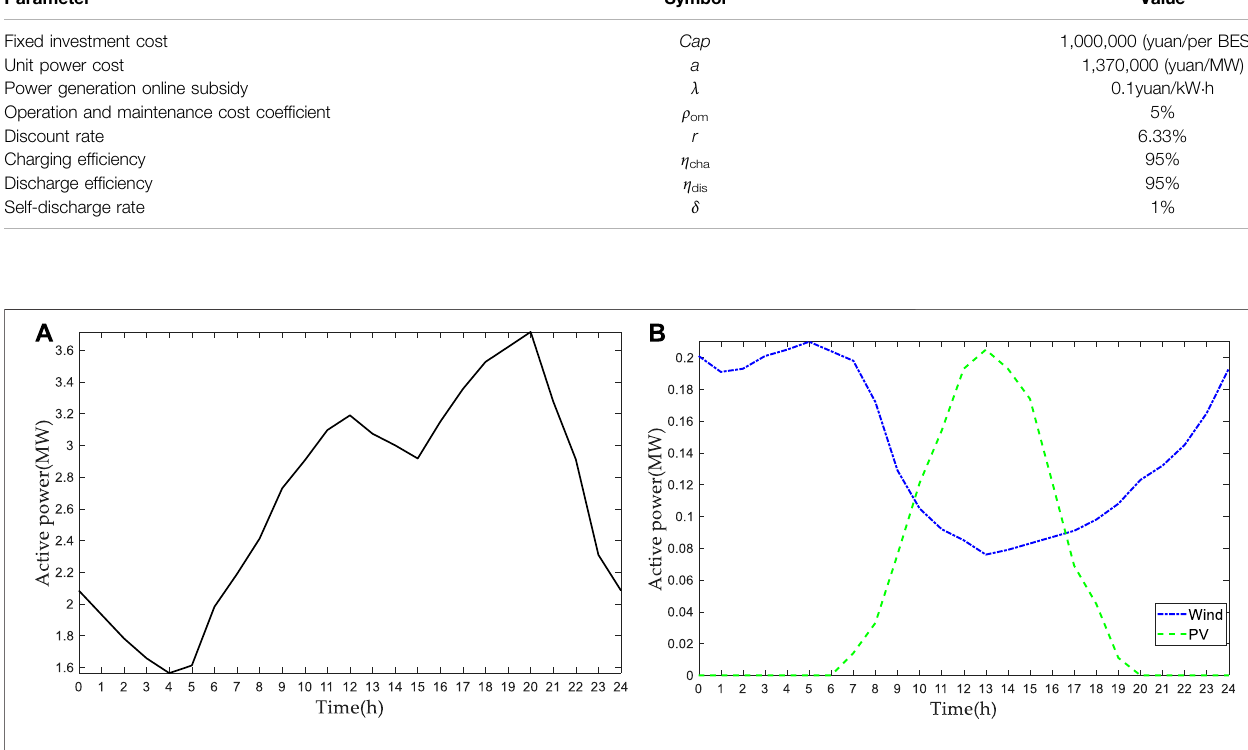
FIGURE 3 | Typical daily curves. (A) hourly load curve. (B) wind and photovoltaic power curve.